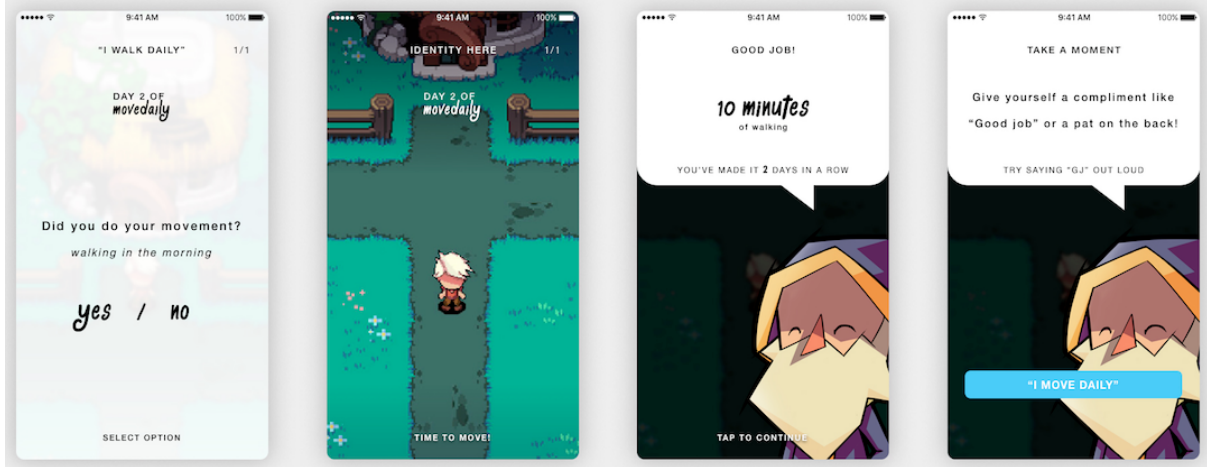
Figure 5. A reaffirmation example of the app MoveDaily. If an activity was performed successfully, the user is complimented and reminded of his or her daily steps